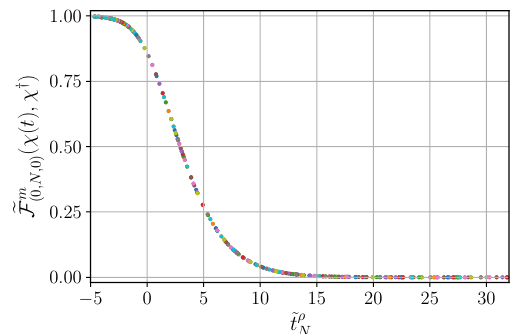
( χ ( t ) , χ † ) for different charge sectors and two values of N Figure 9 . The rescaled OTOC e F m (0 ,N, 0) : m = { 50 , 60 , . . . , 440 , 450 } for N = 500 , and m = { 50 , 60 , . . . , 140 , 150 } for N = 200 , plotted against the transformed time variable ˜ t ρ . The OTOCs for all different m corresponding to both N the values of N collapse into a single